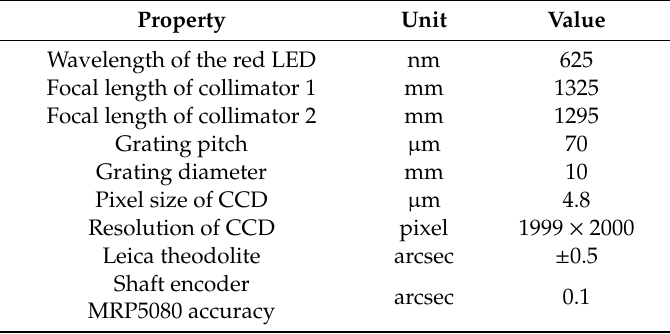
Table 1. Main parameters of experimental setup. CCD, charge coupled device.